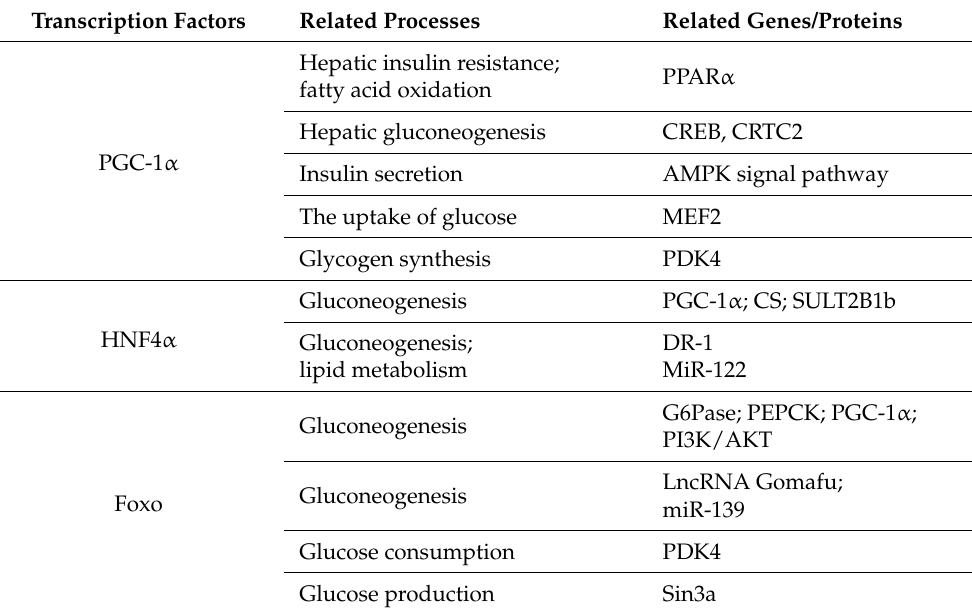
Table 1. Role of important transcription factors upstream of gluconeogenesis in